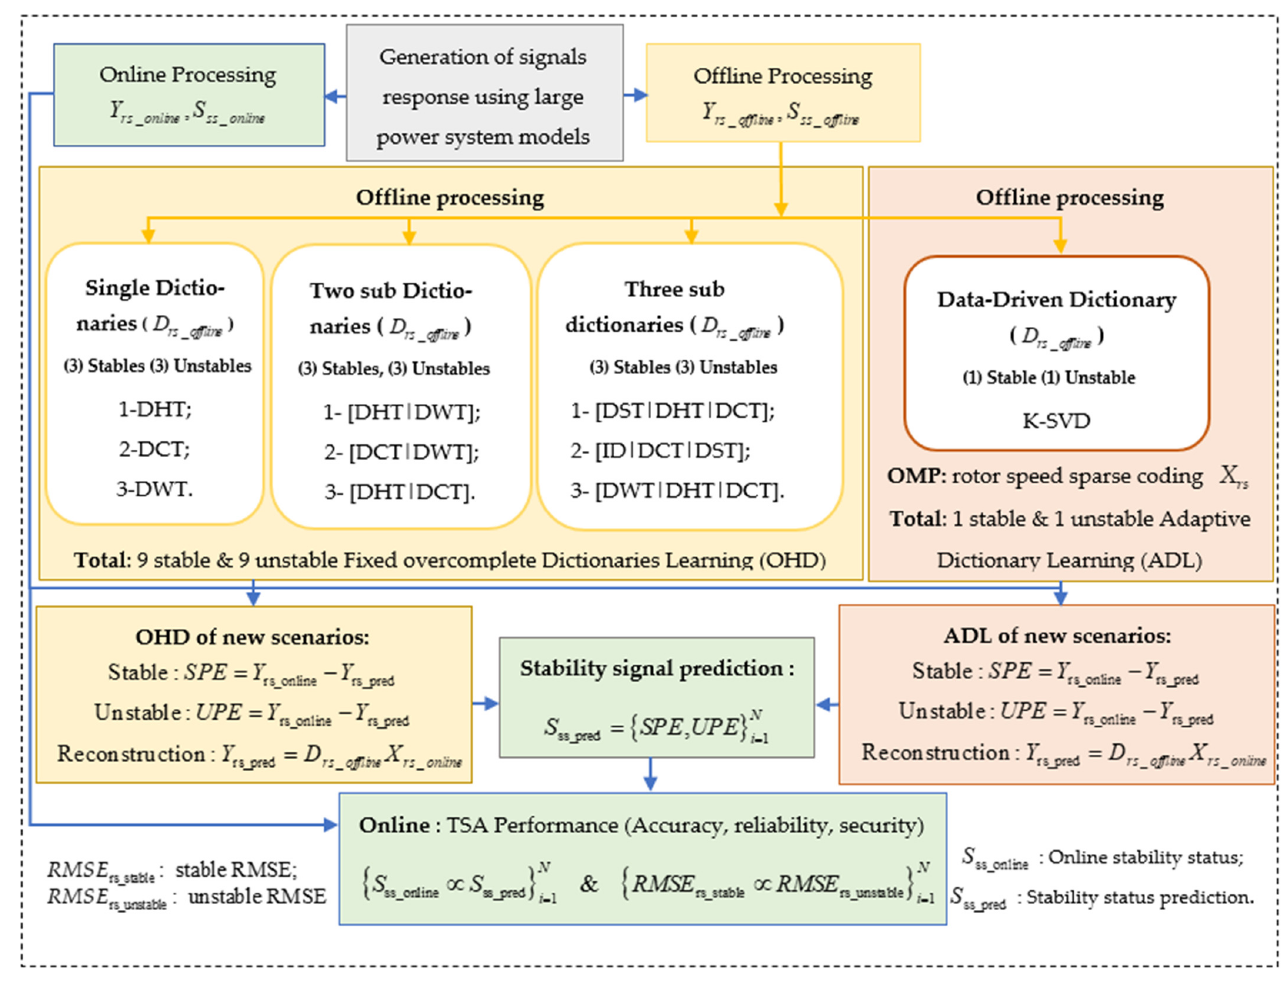
Figure 1. Proposed flowchart of sparse signal decomposition on supervised dictionaries for transient stability assessment.